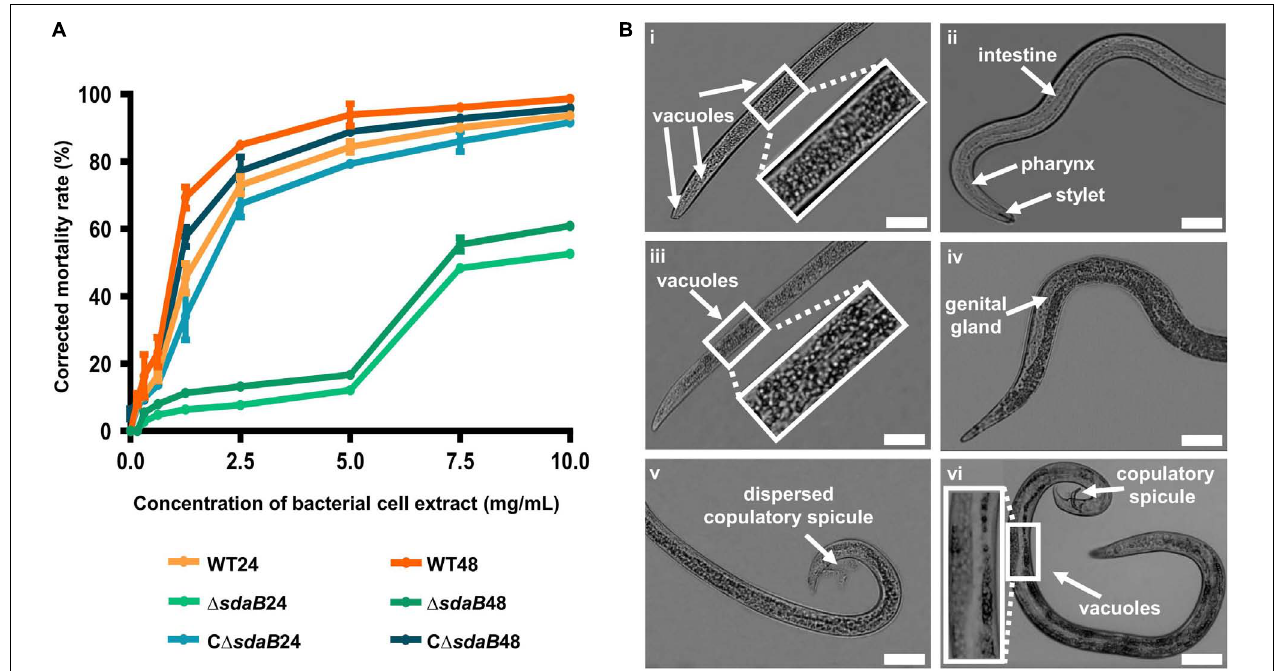
FIGURE 4 | Nematocidal effect of cell extracts of E. ludwigii AA4 and its sdaB gene knock-out mutant against B. xylophilus . (A) Mortality of the B. xylophilus nematode treated with bacterial cell extracts. The worms were incubated with the cell extracts of wild-type AA4 and AA4 (cid:49) sdaB for 24 h or 48 h, respectively. WT24, PWNs treated with a cell extract of wild-type AA4 for 24 h; WT48, PWNs treated with a cell extract of wild-type AA4 for 48 h; (cid:49) sdaB 24, PWNs treated with a cell extract of AA4 (cid:49) sdaB for 24 h; (cid:49) sdaB 48, PWNs treated with a cell extract of AA4 (cid:49) sdaB for 48 h; C (cid:49) sdaB 24, PWNs treated with a cell extract of AA4 (cid:49) sdaB complemented with a wild-type sdaB gene for 24 h; C (cid:49) sdaB 48, PWNs treated with a cell extract of AA4 (cid:49) sdaB complemented with a wild-type sdaB gene for 48 h. (B) Morphological changes of B. xylophilus incubated with the cell extract of wild-type E. ludwigii AA4. The L4 stage worms exposed to a wild-type AA4 cell extract containing total proteins of 5 mg/mL for 24h, are shown in the left column, where the vacuoles in front (i) and back (iii) sections of worm bodies as well as dispersed copulatory spicule (v) are indicated by arrows. Non-treated L4 stage nematodes (ii,iv,vi) are presented in the right row, where the arrows indicate the intestine, pharynx, and stylet (ii) , genital gland (iv) , copulatory spicule and vacuoles (vi) , respectively (scale bars: 1 mm).